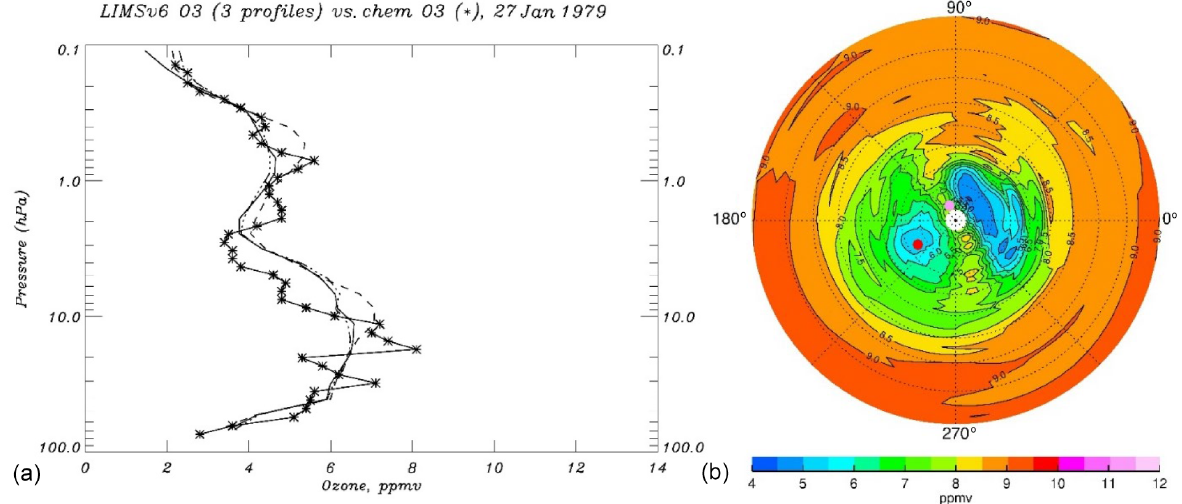
Figure 6. (a) As in Fig. 4 but for 27 January 1979 at Poker Flat, AK (65 ◦ N, 212.5 ◦ E); (b) NH V6 distribution of ozone at 4.6hPa, where CI is 0.5ppmv. Latitudes (dotted circles) are spaced every 10 ◦ ; Poker Flat is red, and satellite position (81 ◦ N, 113 ◦ E) is